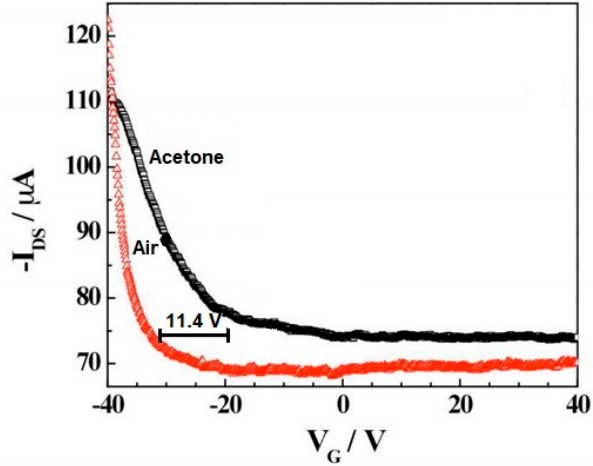
Figure 5. Transfer characteristic of iron tetraphenyl porphyrin-CNT in the presence of air and acetone. V G —gate voltage, I DS —the source-drain current. Reprinted with the authors’ permission [21]. The amount of voltage shift has been marked.